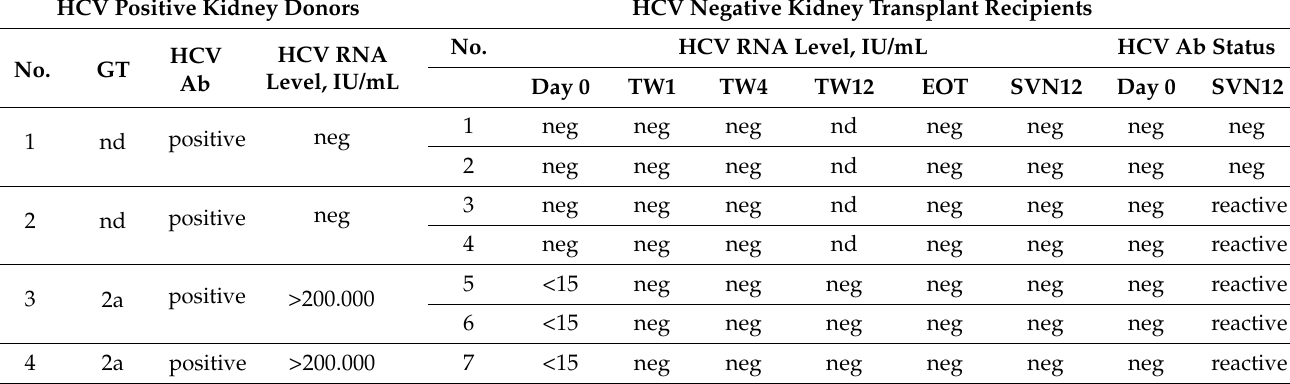
Table 2. Efficacy outcome